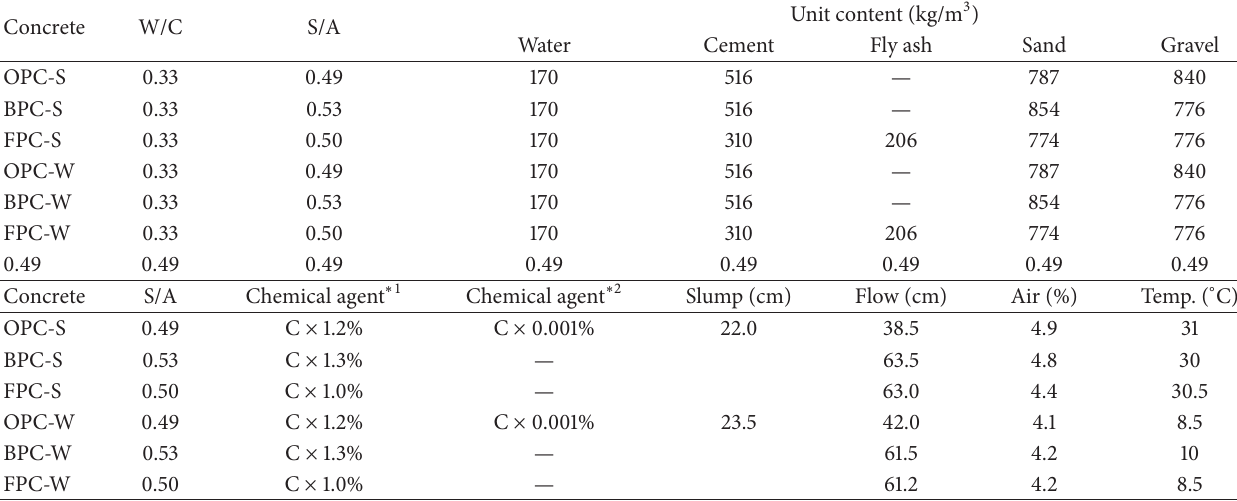
Table 3: Mix proportions and properties in fresh